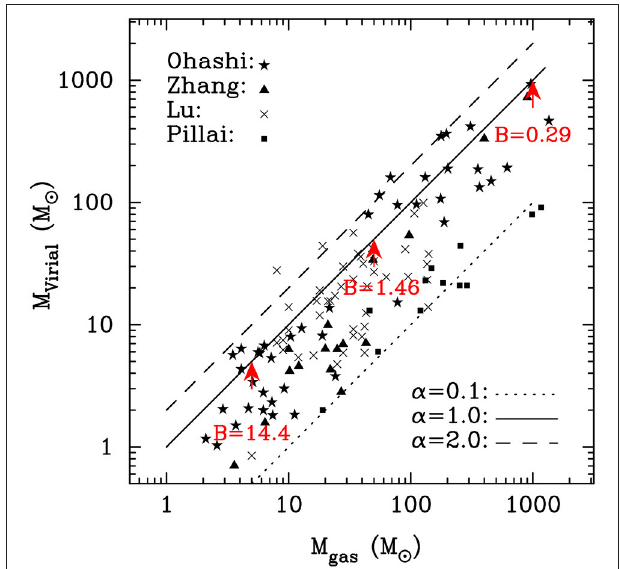
FIGURE 9 | Virial mass M Virial vs. gas mass M gas for clumps and cores in 12 high-mass star forming regions. The data were taken from Pillai et al. (2011), Zhang et al. (2015), Ohashi et al. (2016) and Lu et al. (2018). The virial mass includes contributions from thermal and non-thermal line widths. The gas mass was derived from dust continuum emission. The dashed, solid, and dotted M Virial / M gas of 2, 1, and 0.1, respectively. lines denote virial parameters α vir = The majority of the data points have α vir < 1, indicating that clumps and cores are far from virial equilibrium when contributions from magnetic fields are not included. The red arrows indicate the strength of the magnetic field (in mG) that are required to increase α vir from 0.5 to 1.0 (see section